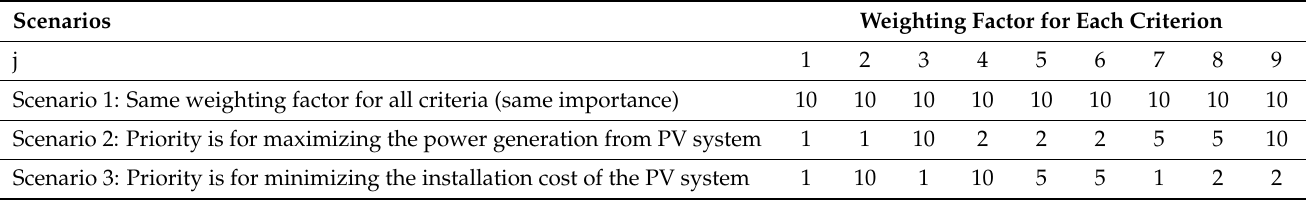
Table 4. Three scenarios with different weighting factors are used to compare RWR and technique for order of preference by similarity to ideal solution (TOPSIS)